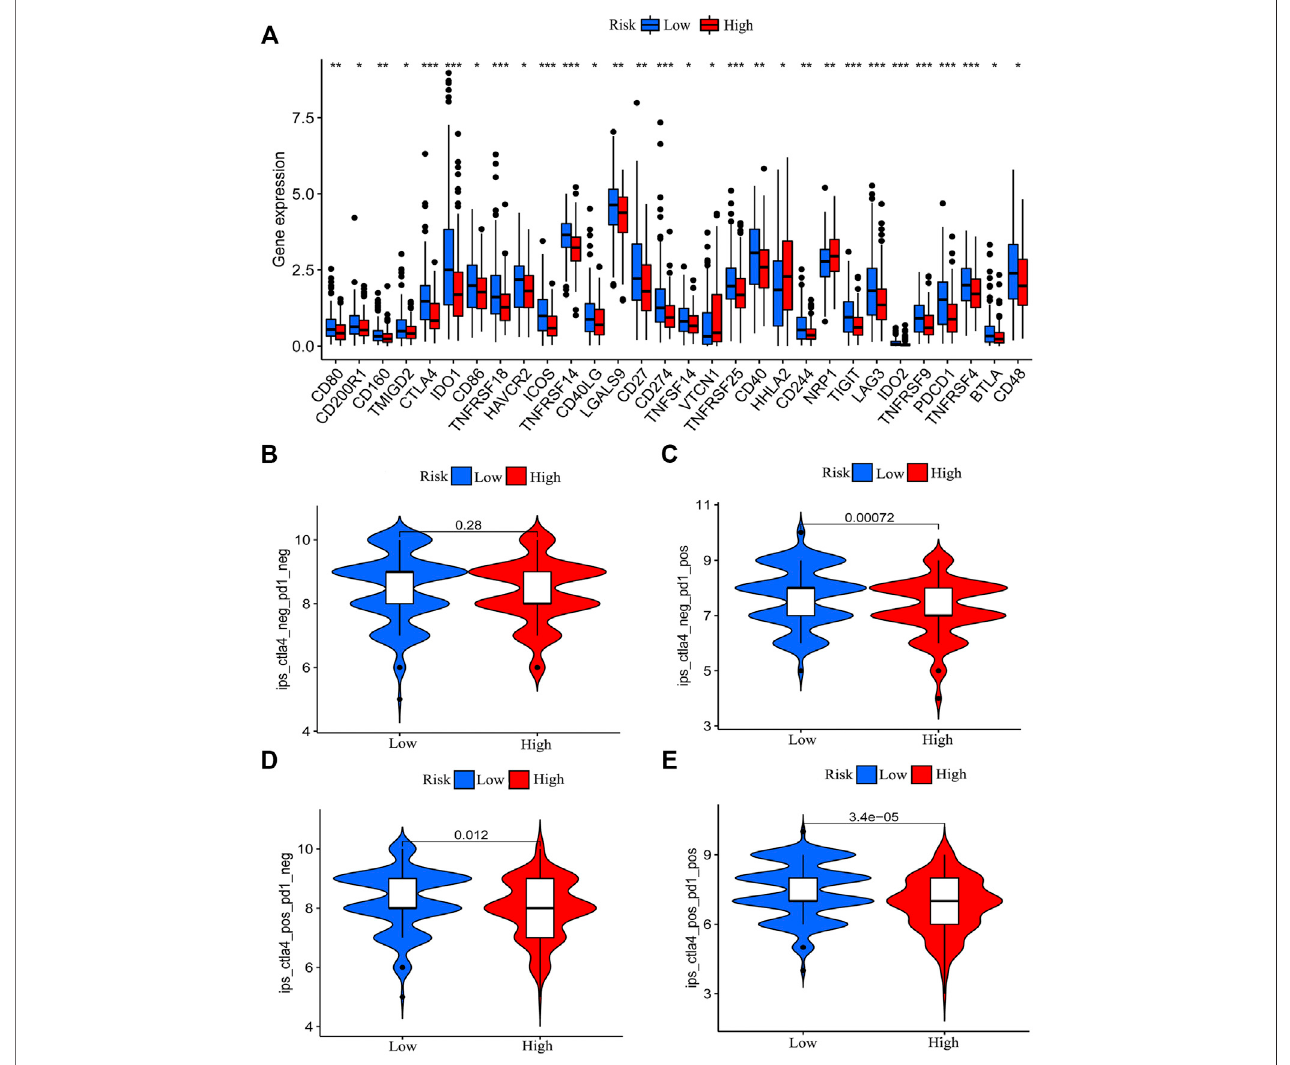
FIGURE 7 | Correlation between risk model and immune checkpoint genes and immunotherapy score. The difference in the expression of immune checkpoint genes between the low-risk group and the high-risk group was determined (* p < 0.05, ** p < 0.01, *** p < 0.001) (A) . The immunotherapy scores of patients with positive status of CTLA4 or PD-1 in the low-risk group patients are higher than that of high-risk group patients (B – E) .